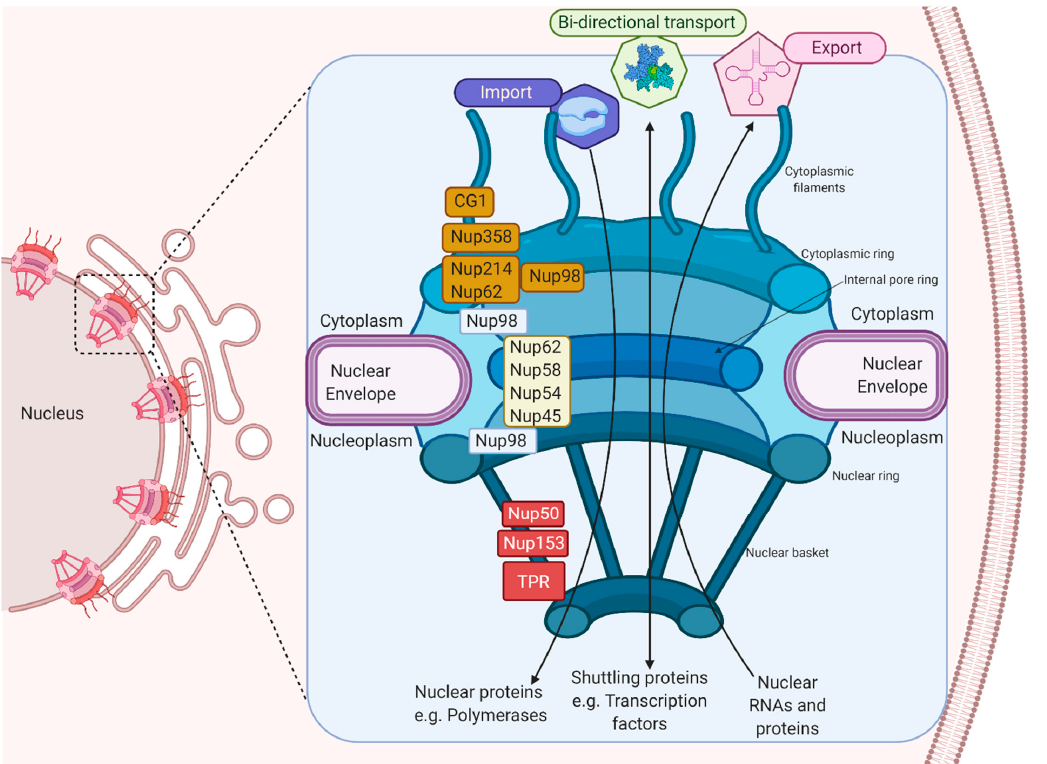
Figure 1. The machinery of the Nuclear Pore Complex. The NPC’s different components, which participate in the import and export of proteins and RNAs, and the FG-Nups, which participate in nuclear–cytoplasmic transport, are shown.